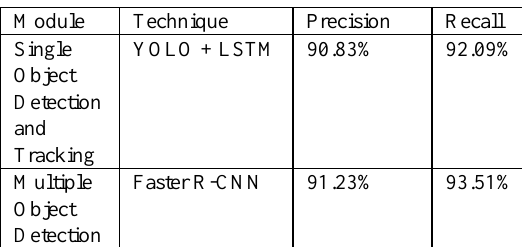
Table 1. Performance metrics of interactive